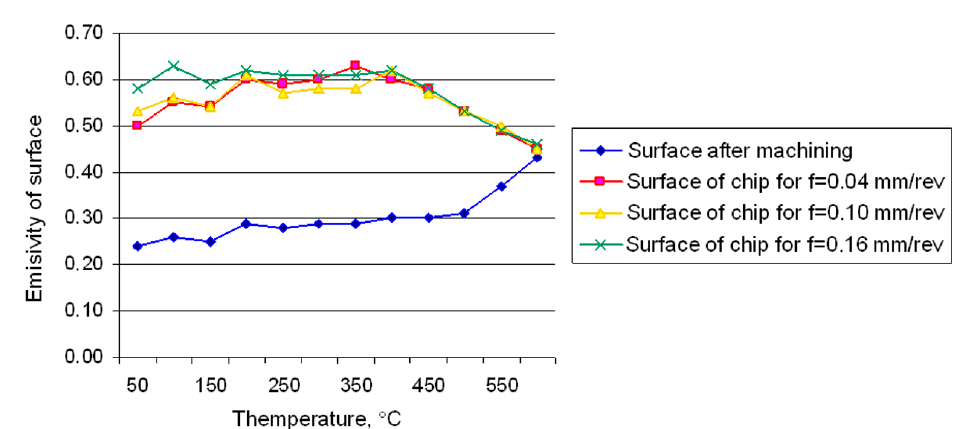
Figure 4. Changes in the emissivity factor of the chip surfaces and AISI 321 after turning versus temperature [6].